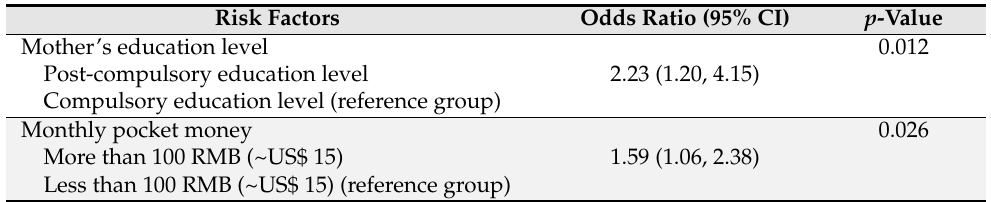
Table 4. Gingival bleeding risk factors for the Hani children (multivariate logistic regression, N = 413). Risk